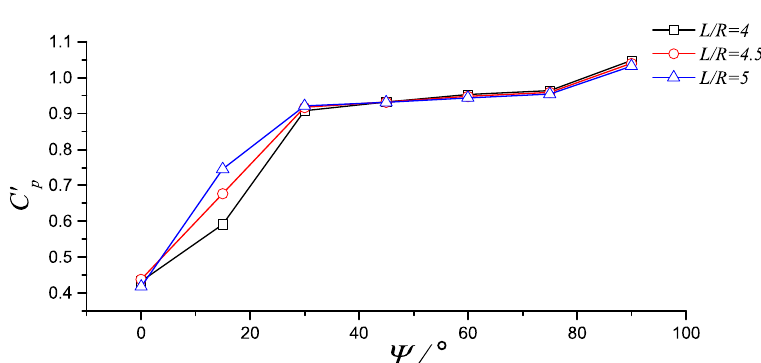
Figure 16. Influence of deflection angle on hydrodynamic characteristics of hydraulic turbine where Z = 2.